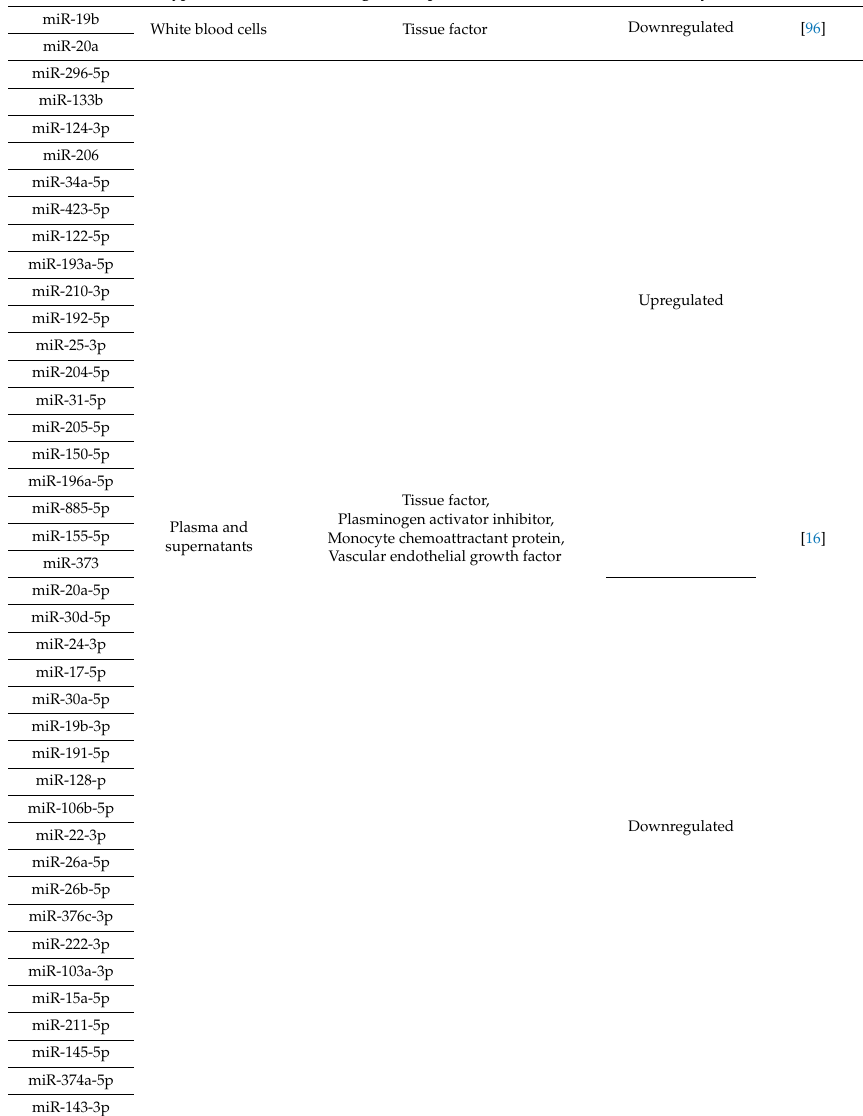
Table 1. Changes in miRNA expression between primary and secondary antiphospholipid syndrome (APS) and healthy controls. miRNA Type of Cells Target (or Population Studied) Activity